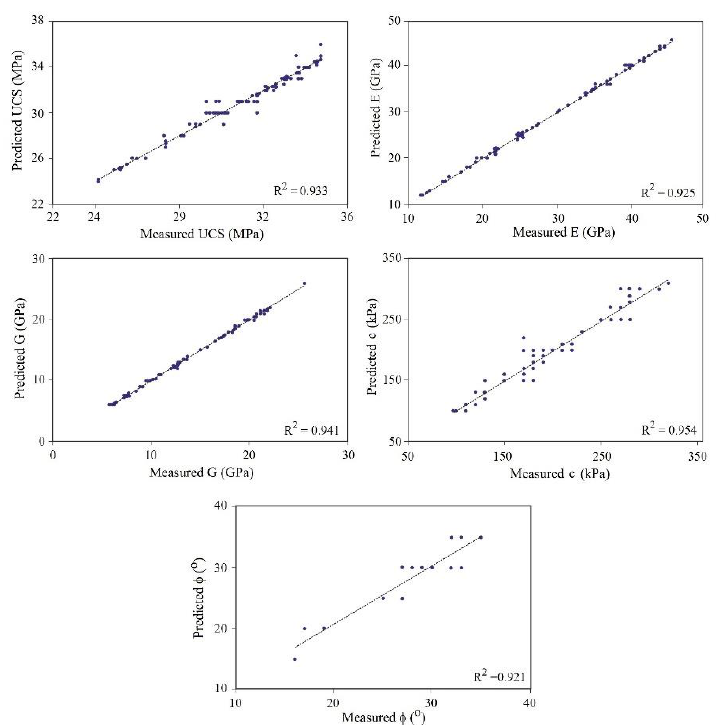
Figure 5. Correlation between the measured data and the predicted model for the geotechnical values.